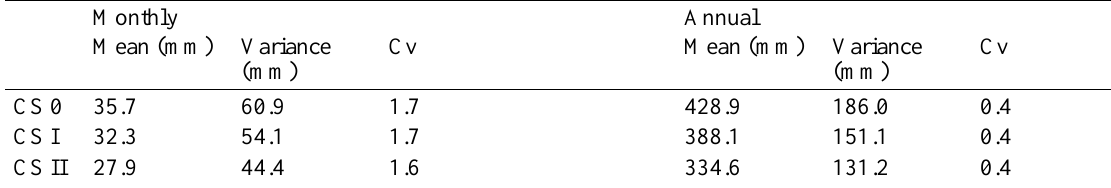
Table 1 Net rainfall statistics at the monthly and annual scale, for different climate